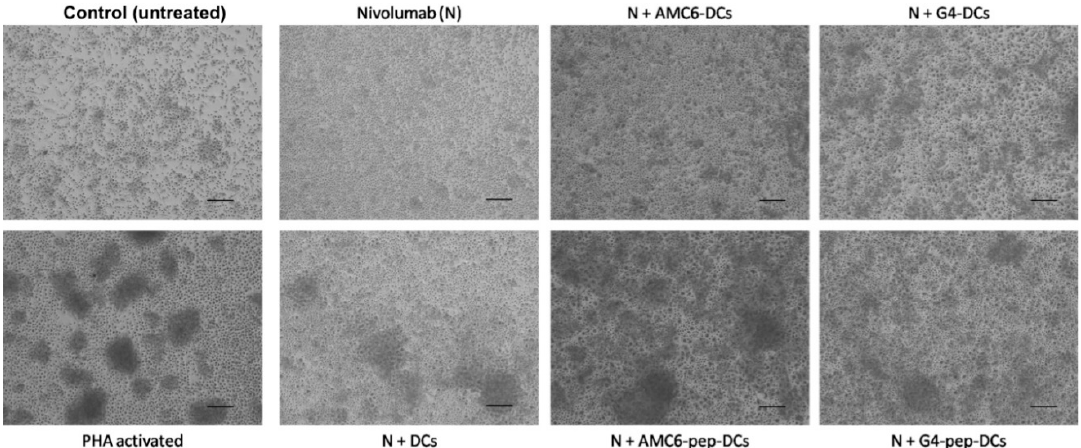
Figure 6. Cell proliferation after MLR observed by brightfield microscopy. PBMCs were cultured for 5 days in the MLR, with DCs treated with AMC6 nanoparticle or G4-70/30 dendrimer, with or without the p42 peptide, in the presence of nivolumab. Untreated DCs were used as control as well as nivolumab alone (without adding DCs). In addition, untreated PBMCs were used as control of no proliferation, and PHA activated PBMCs were used as control for DC activation and proliferation. Scale bar: 100 µm. Abbreviations: G4 = G4-70/30, pep = peptide.